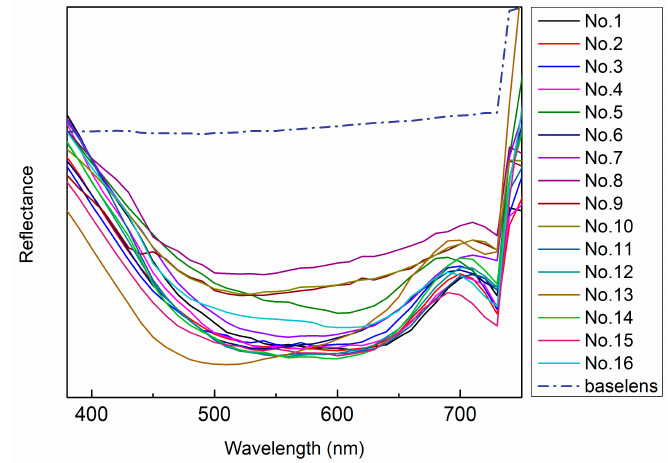
Figure 4. Reflectance spectra of base-lens without AR coatings and lens sample of No. 1–16 with AR coatings. Based on AR coating on No. 1–16 lenses, reflected light intensity decreases compared to the base-lens without AR coatings.